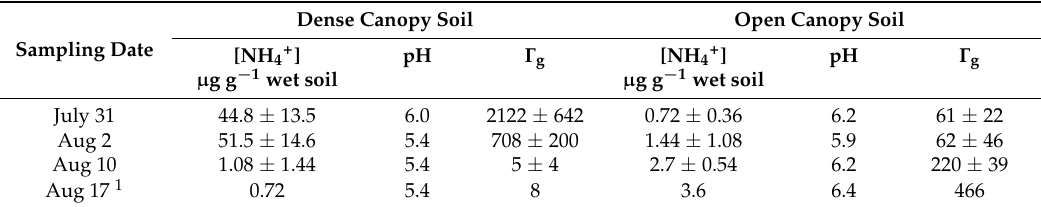
Table 1. Extracted [NH 4+ ], soil pH and resulting Γ g in open and dense canopy areas of MEFO.